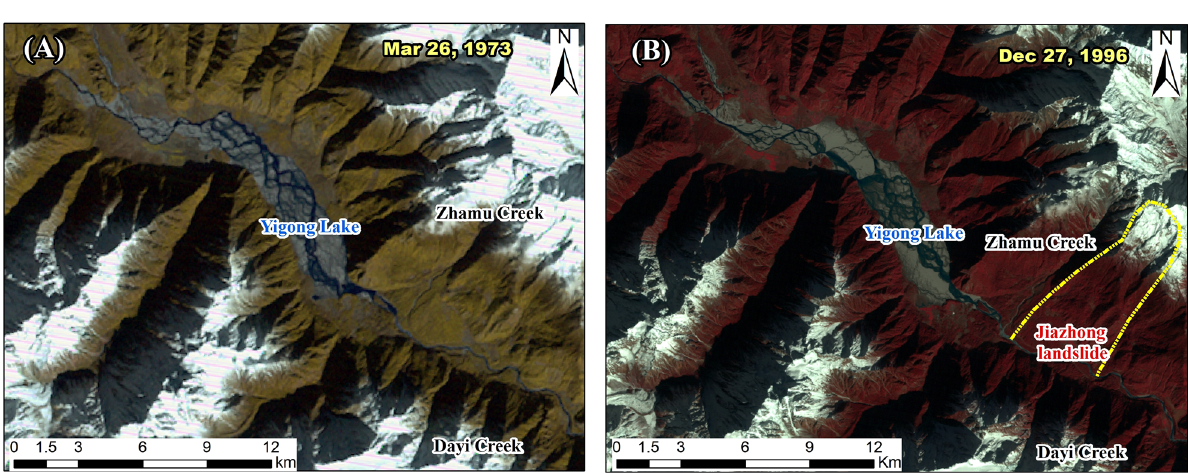
Figure 7. ( A ) KeyHole-9 satellite image of Yigong Lake on March 26, 1973, and ( B ) TM satellite image of Yigong Lake on December 27, 1996. The yellow outline marks the ancient landslide at Jiazhong village. The maps were created using a licensed ArcGIS 9.3 software (https:// suppo rt. esri. com/ en/ downl